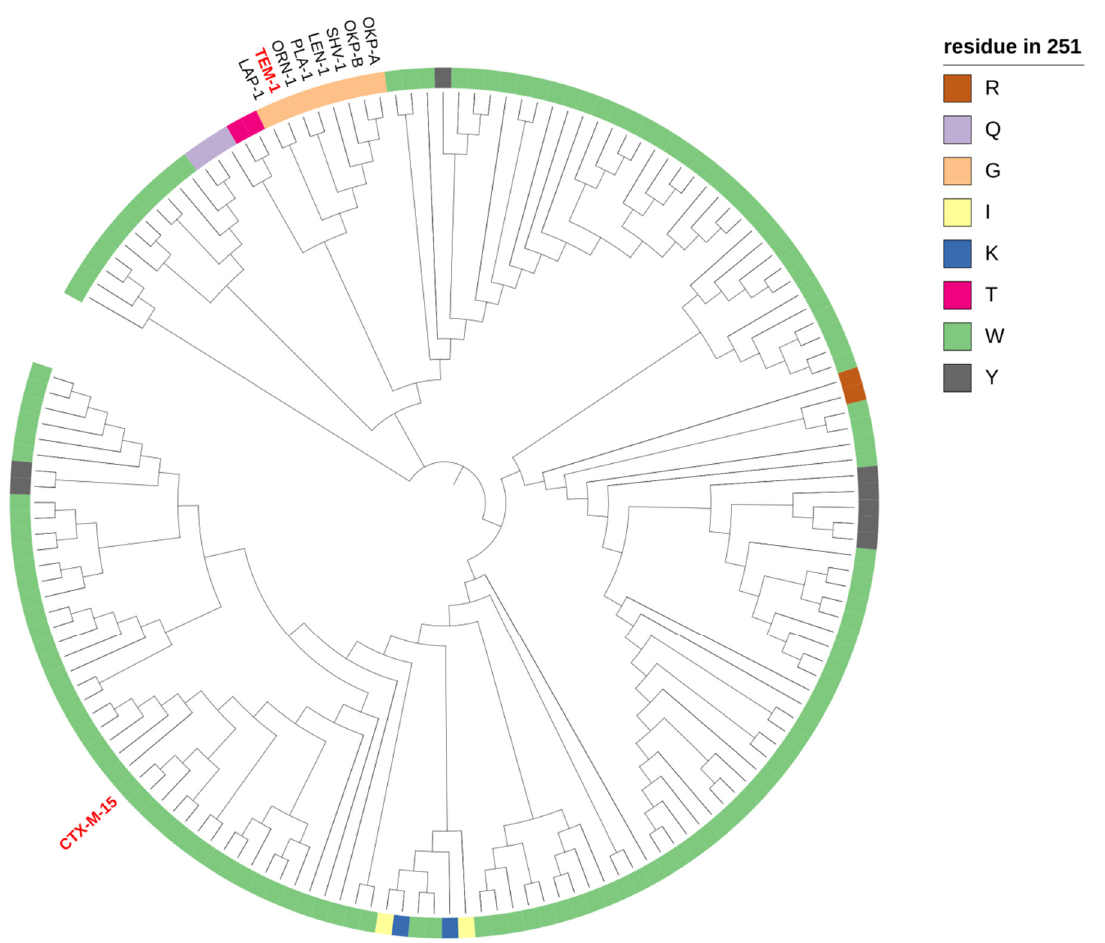
Figure 2. Phylogenetic tree of 157 class A beta-lactamases [9]. The different colors indicate the diversity at position 251. Beta-lactamases with a G251 are labeled in black, and TEM-1 and CTX-M-15 beta-lactamases are labeled in